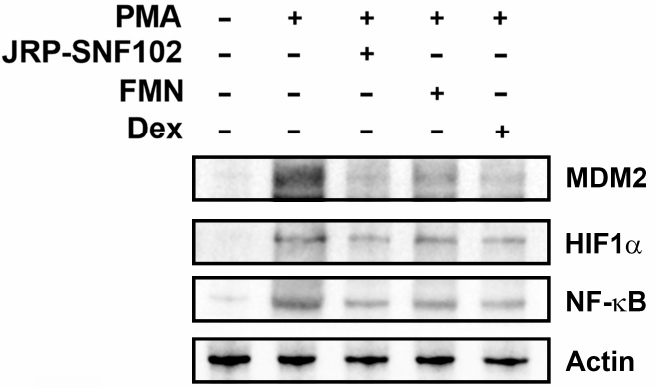
Figure 5. A suppressive effect of JRP-SNF102 or FMN on TSLP levels in PMA-induced ear edema. ( A ) The photographs of ear biopsies were obtained after ear thickness analysis. The ear biopsies were prepared for determining ( B ) TSLP and ( C ) VEGF levels by ELISA. ( D ) In the ear biopsies, c- kit (+) and TSLP (+) cells were observed with a confocal microscope, scale bar = 50 µm. ( E ) TSLP and ( F ) VEGF levels in serum samples were quantified by ELISA. ### p < 0.001 versus normal group; *** p < 0.001 versus PMA-challenged groups. n = 6. -, non-treatment; +, treatment.